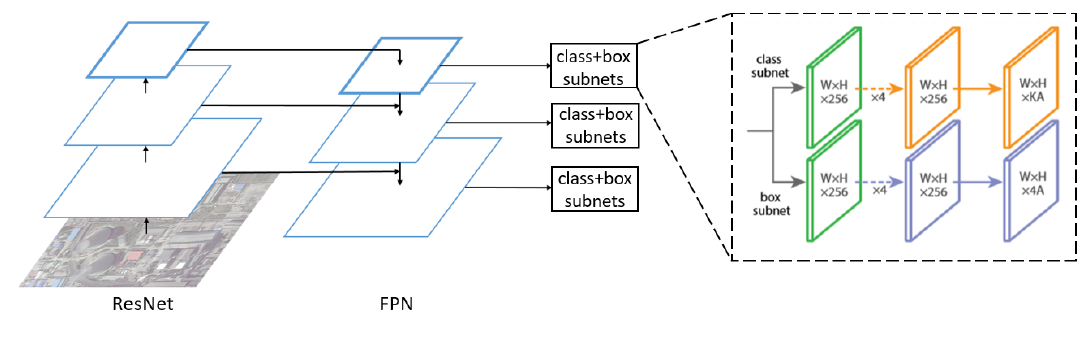
Figure 8. The framework of RetinaNet. FPN, feature pyramid